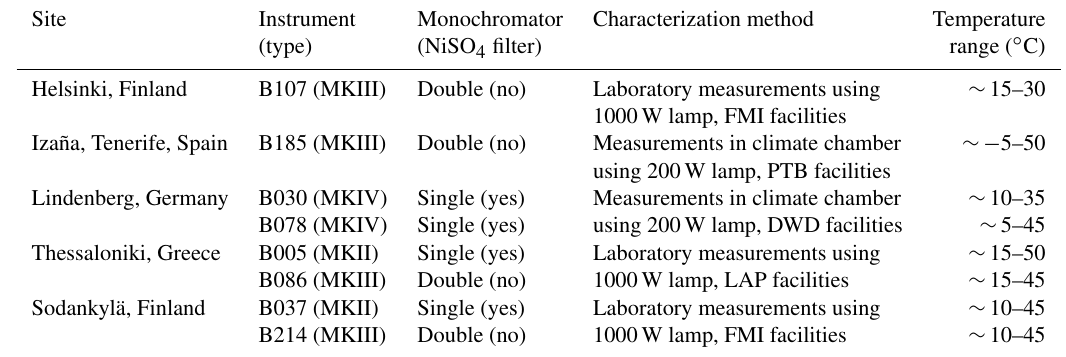
Table 1. Information for each Brewer spectrophotometer and the corresponding temperature characterization